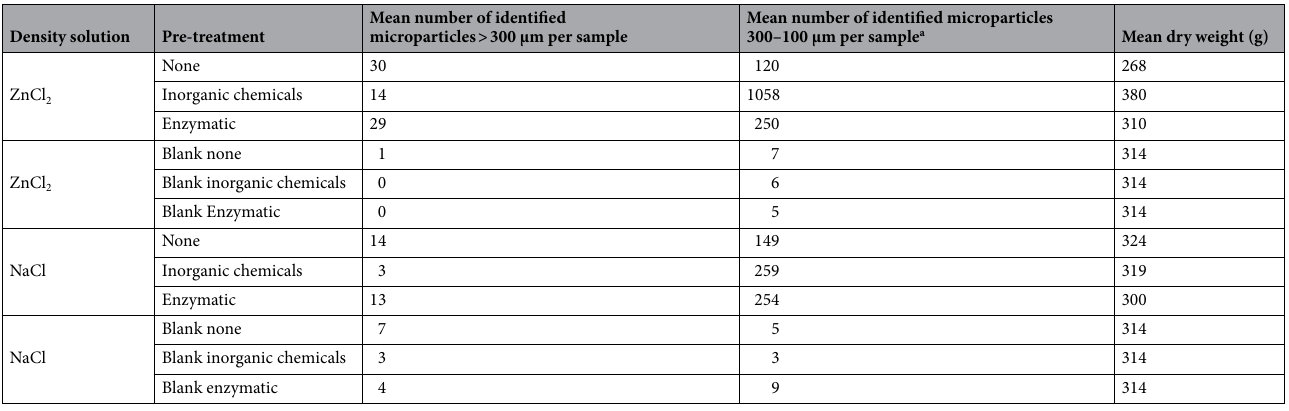
Table 1. Identified microparticles in blank samples and sediment samples treated with inorganic chemicals, enzymes and with no treatment for both density separation solutions, ZnCl 2 and NaCl. a Includes anthropogenic particles identified from the supernatant of washed